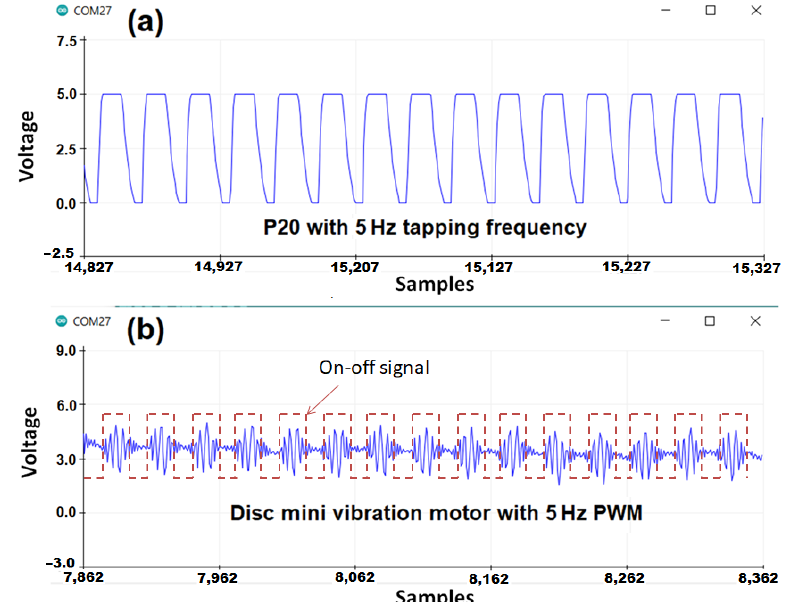
Figure 13. Tapping vs buzzing vibration. ( a ) Tapping: 5 Hz vibration has clear and distinct vibrations. ( b ) Buzzing: The low-frequency 5 Hz on–off signal for the vibration motor (in red dotted lines) has a high-frequency buzzing vibrations (in blue spikes). The inherent high-frequency vibrations within low-frequency on-time is due to the rotating mass inside the vibration motor running at 14,000 rpm or around 230